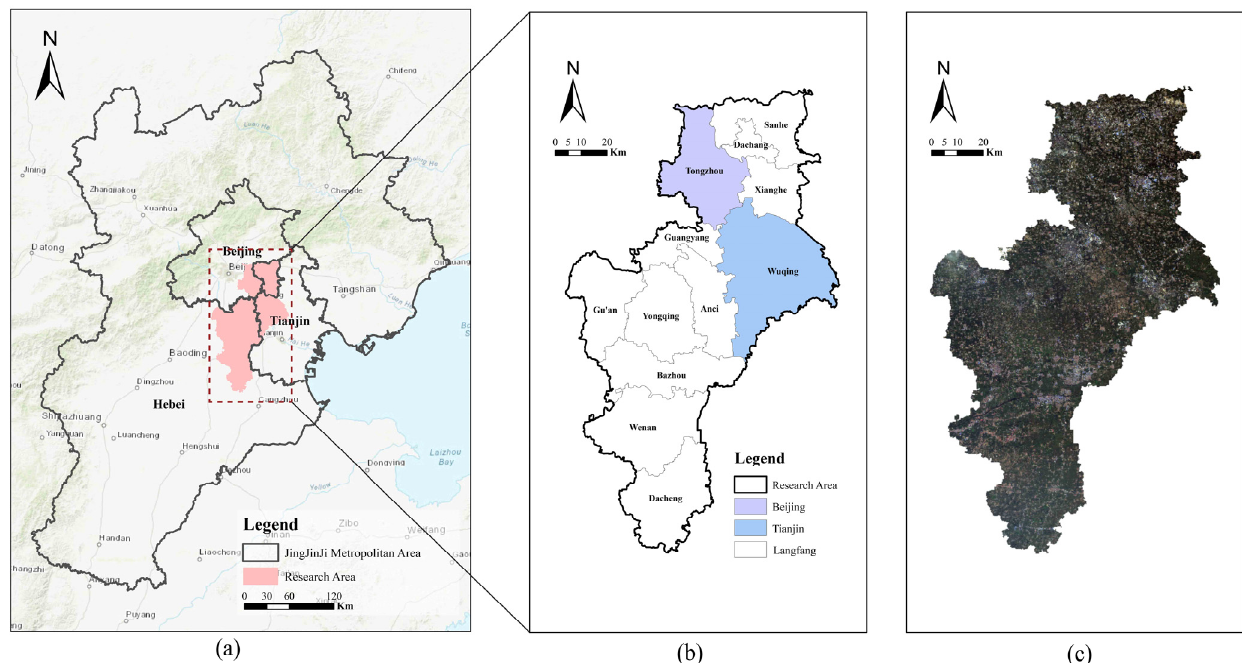
Figure 1. ( a ) Beijing-Tianjin-Hebei Metropolitan Region, ( b ) administrative map of TWL region, and ( c ) remote sensing image of TWL region (Source: authors based on United States Geological Survey).